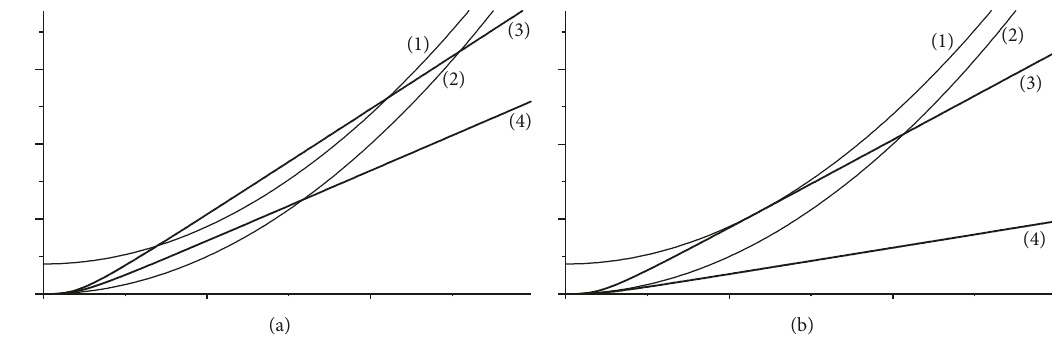
Figure 2: Four cases for the existence of ergospheres and